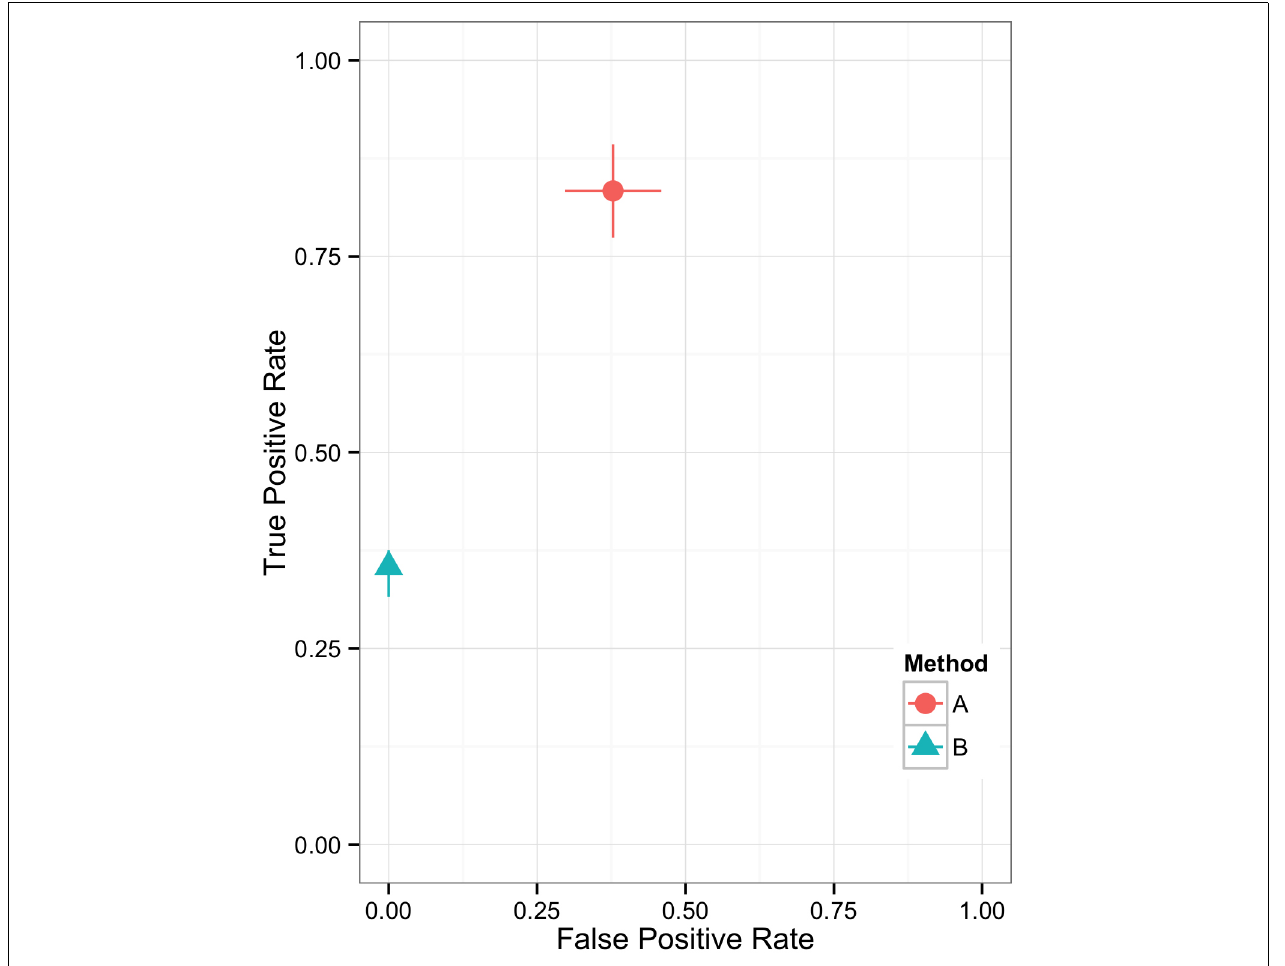
FIGURE 5 | Scatter plot showing the relationship between two performance metrics for variant call sets. The individual data points are based on metrics calculated from static contingency tables. The error bars represent the 95% confidence interval for each performance